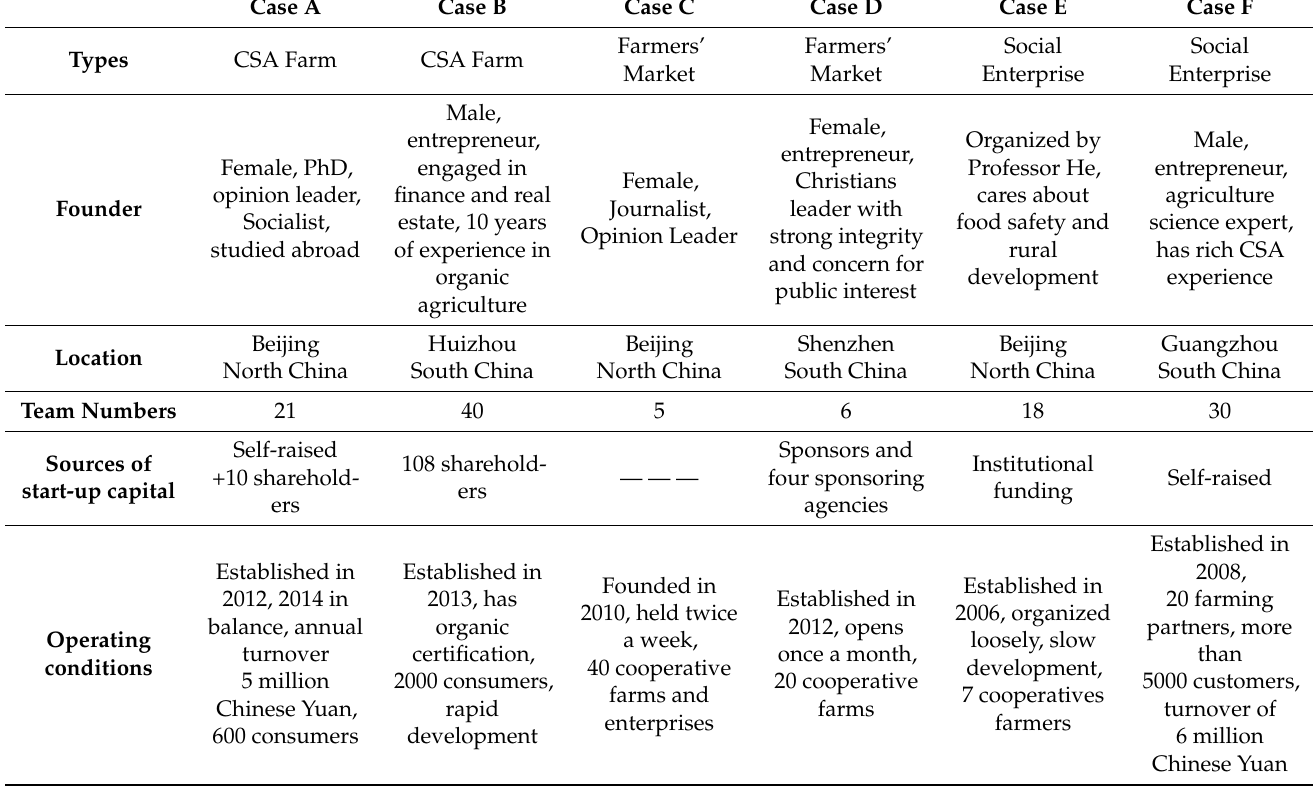
Table 1. Description of